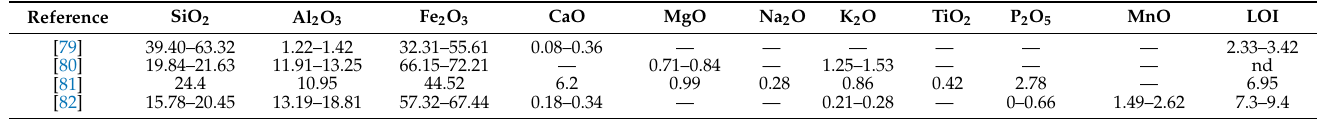
Table 1. Chemical composition (expressed wt.% oxide) of iron mining waste.